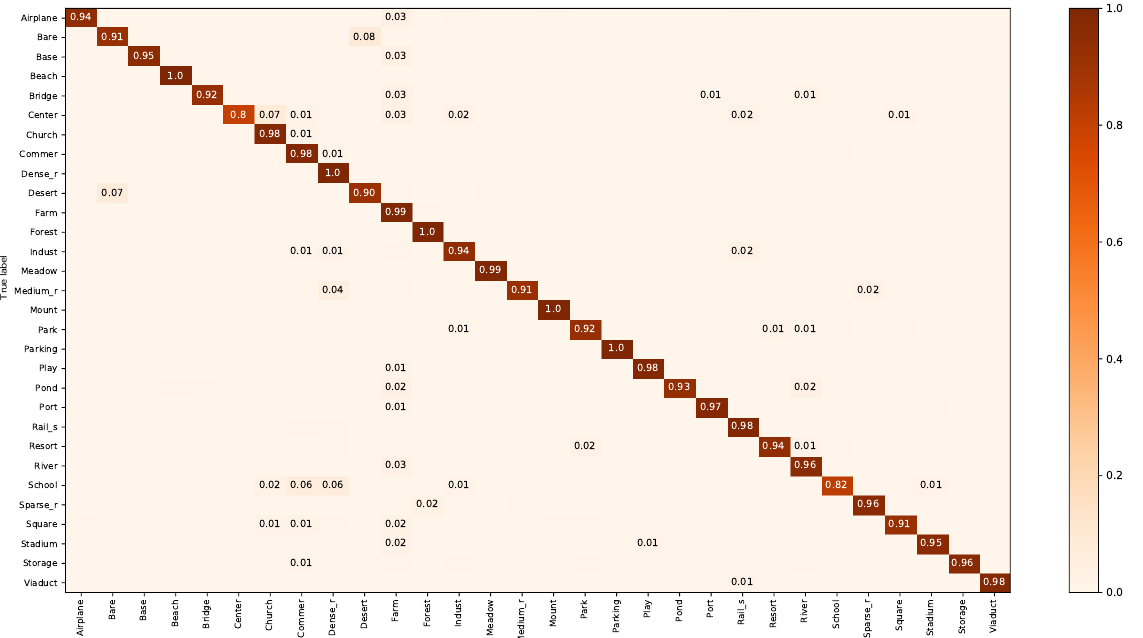
Figure 13. CM of the AID dataset for a 50% training ratio (only displays results greater than 0.01). Table 5. Performance comparison on the NWPU dataset (—-: not reported). Methods